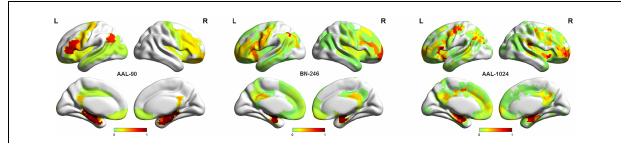
FIGURE 6 | The probability mappings of the selected abnormal features in permutation test with three different